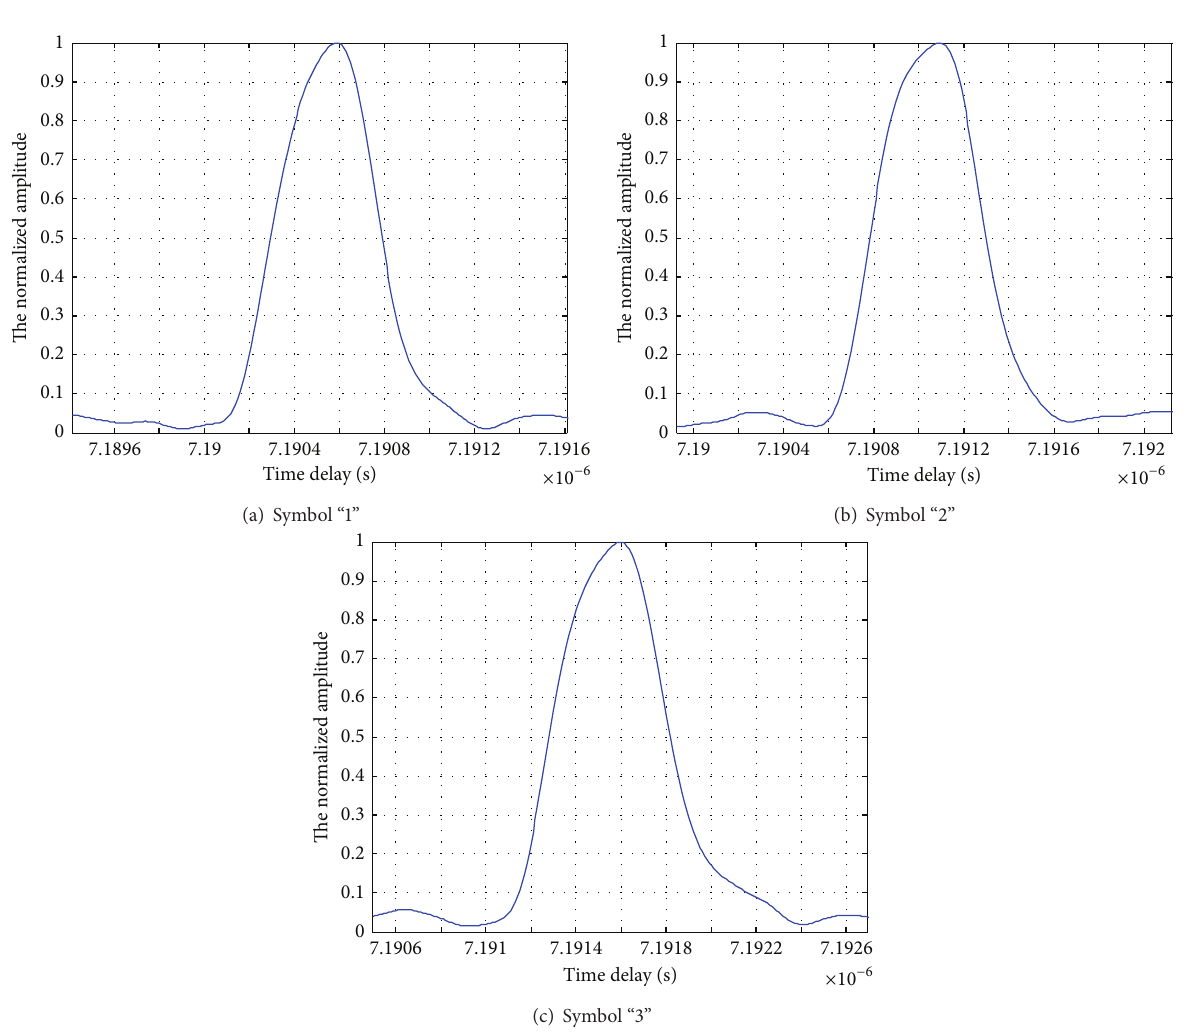
Figure 8: Local enlarging graph for symbols “1,” “2,” and